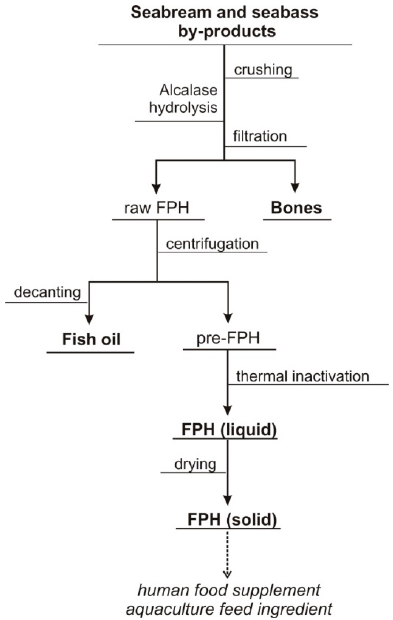
Figure 2. Flowchart defining the steps for the production of FPH from seabream and seabass Figure2. by-products.